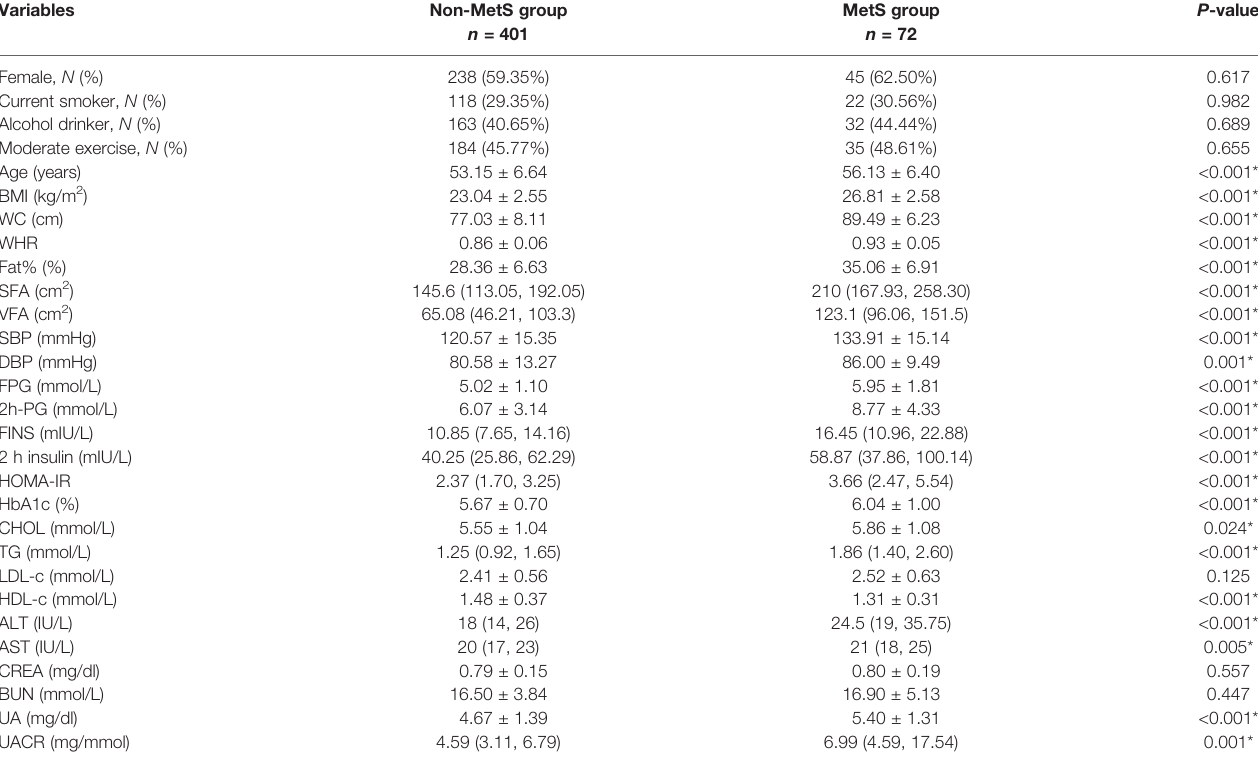
TABLE 1 | Comparison of general clinical characteristics and biochemical indicators between the MetS group and non-MetS group.